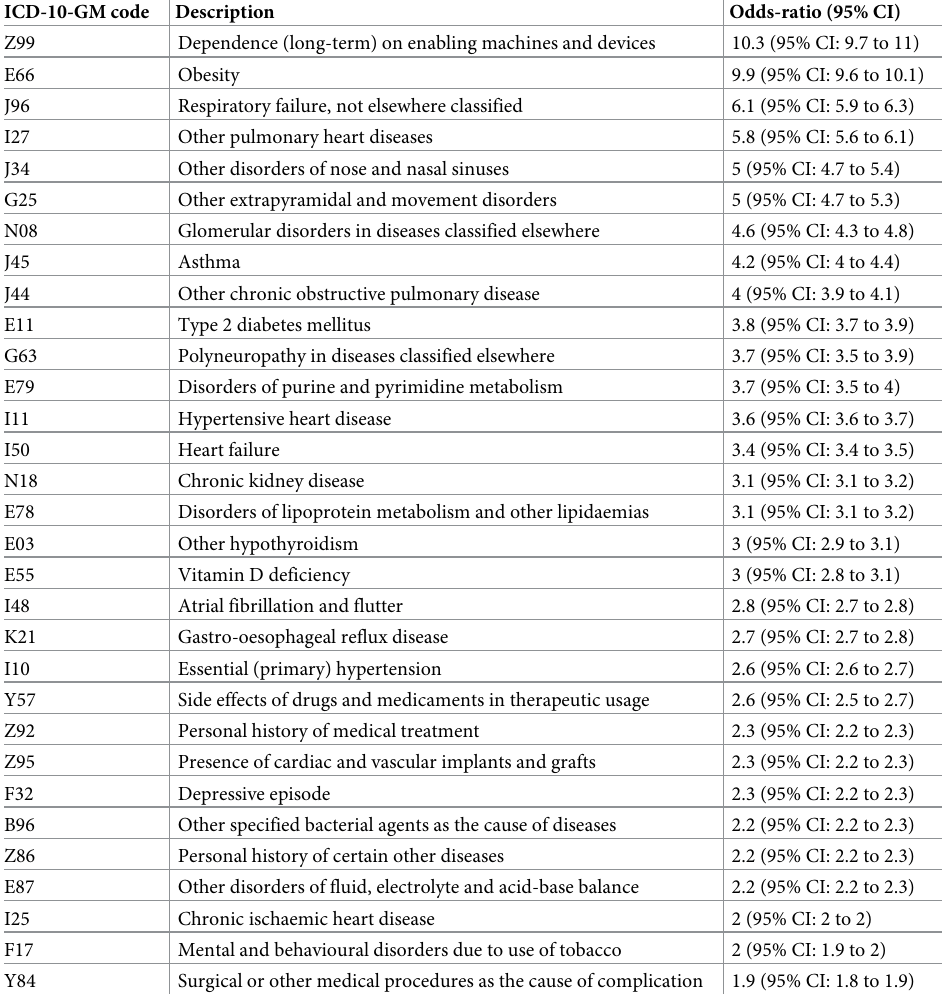
Table 2. List of comorbidities significantly over-represented in SA compared to the matched-control population. The simplified ICD-10-GM codes including 2 digits are presented together with a short description and the associated